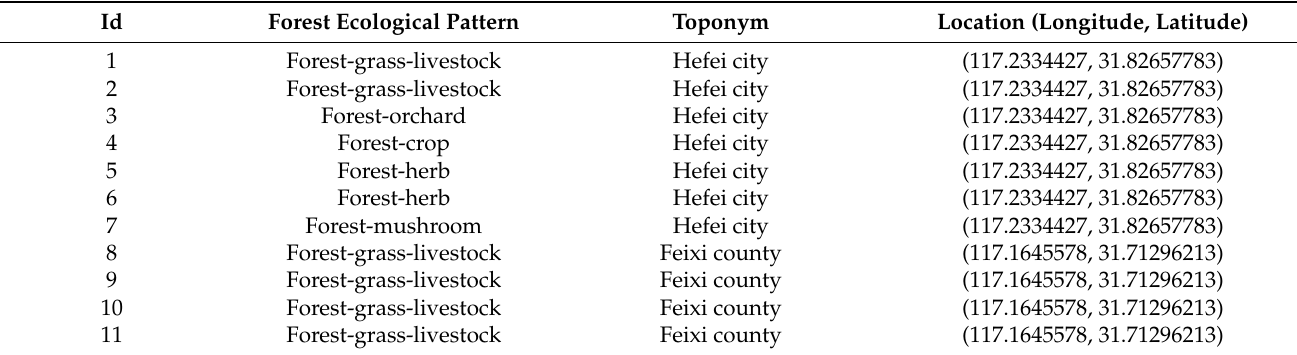
Figure 5. Study area in experiments. ( a ) National Chinese forest ecological pattern distribution and density. ( b ) The case study city, Hefei. Table 1. The examples of forest ecological patterns in Hefei.